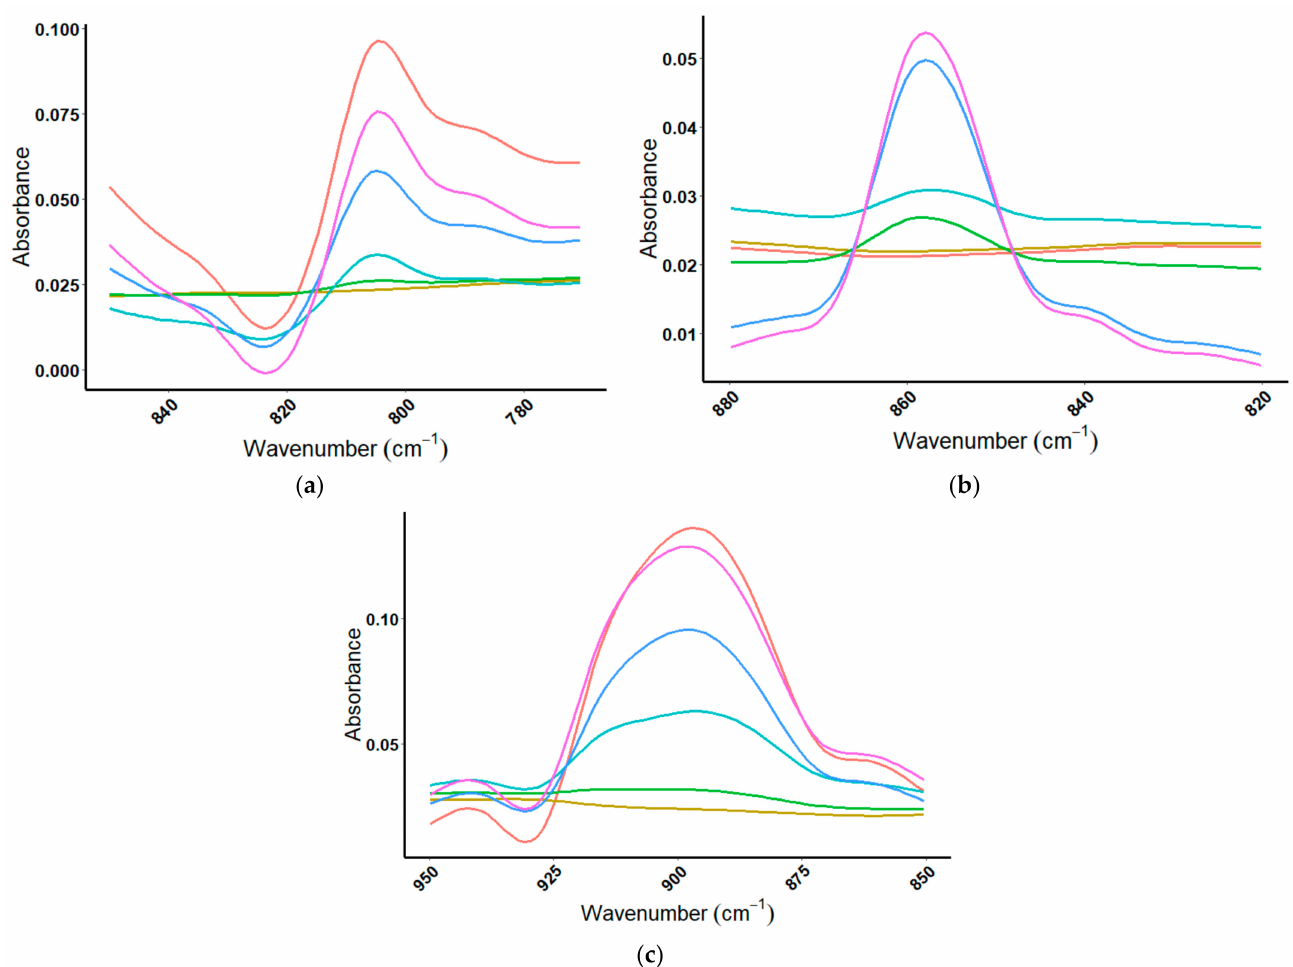
Figure 10. MIR spectral overlays for ISO100 with increasing amount of amino acid to a ratio of 1:3. ( a ) Doping with the amino acid glutamic acid spike in the range of 850–770 cm − 1